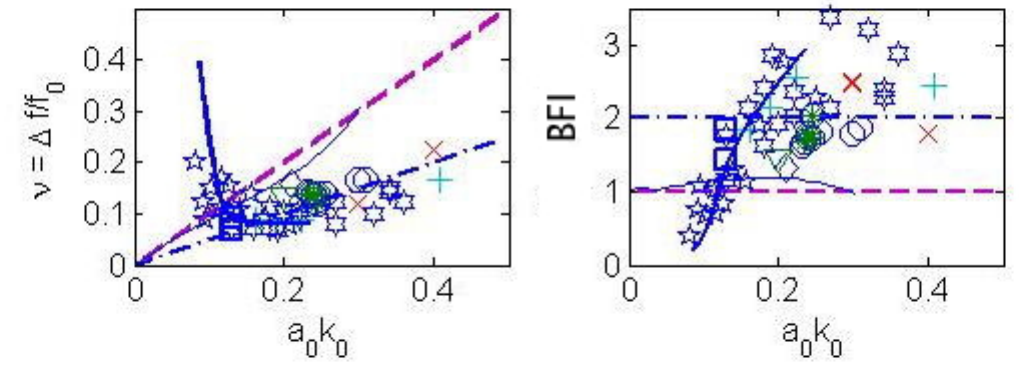
Figure 3. Bandwidth ν = ∆ f / f 0 (left panel) and modulational index BFI (right panel) versus steepness ε = a 0 k 0 . Circles indicate waves with f 0 = 1.6 Hz, crosses with f 0 = 1.8 Hz, pluses with f 0 = 2.0 Hz. Diamond is the [12] point and triangle the [14] point. Pentagrams and hexagrams are from the additional experiments in the tanks of UT and NCKU, respectively. All data, except filled circles, are for no wind forcing. Squares and thick solid lines (blue) correspond to parameterisations of the field spectra of wind-generated waves (JONSWAP, [29] and DHH, [28] respectively). The dash-dotted line (blue) is ν = 0.5 × a 0 k 0 . The small-amplitude theory of [1] for the fastest-growing instability is shown with dashed lines (magenta), and the high-order-non-linearity theory of [4] with thin solid lines (blue) (following